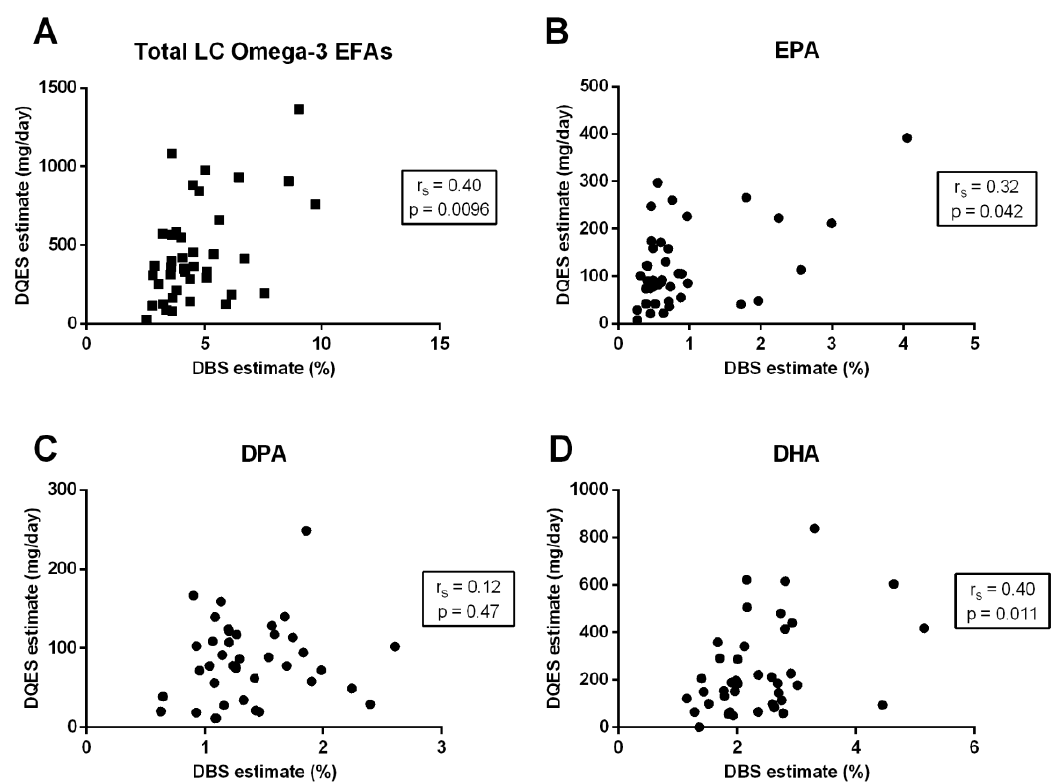
Figure 2. The relationship between total long-chain (LC) omega-3 essential fatty acids (EFAs) percentage (%) present in erythrocytes, measured using dried blood spot (DBS) biomarkers, and the dietary LC omega-3 EFA intake estimated using the Dietary Questionnaire for Epidemiology Studies (DQES) v3.2 for ( A ) total LC omega-3 EFAs, ( B ) eicosapentaenoic acid (EPA), ( C ) docosapentaenoic acid (DPA), and ( D ) docosahexaenoic acid (DHA). Correlation coefficients are calculated using the Spearman’s correlation coefficients (r s ).